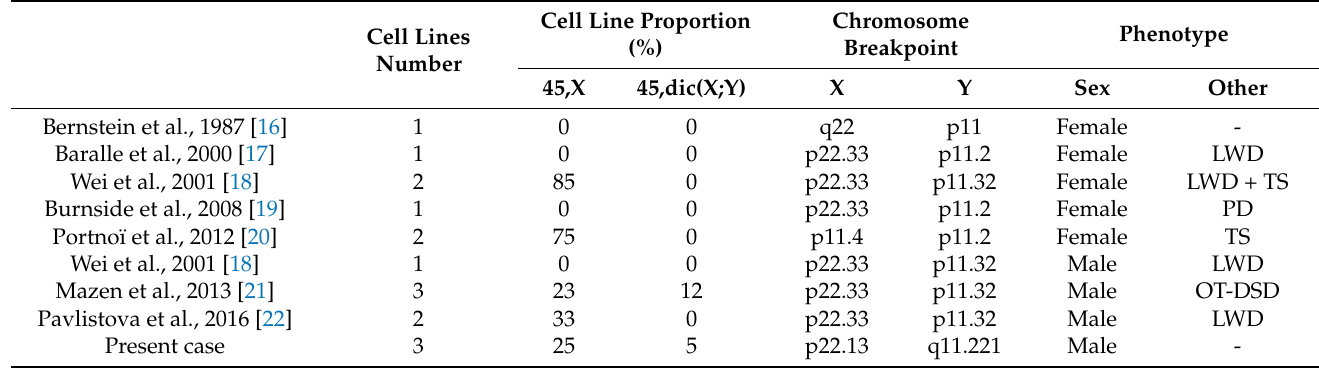
Table 1. Cases of idic(X;Y) reported in the